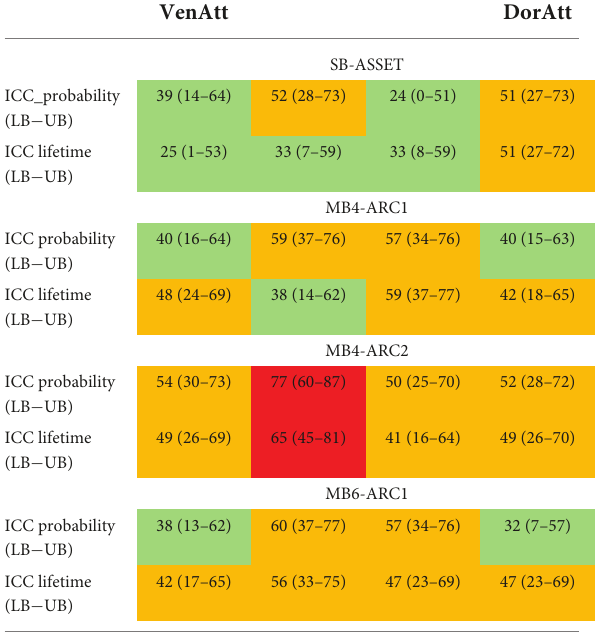
TABLE 2 Reliability of probabilities and lifetimes across three time points for the four modalities. Yeo networks SMot and Visual DMN FrPar and VenAtt